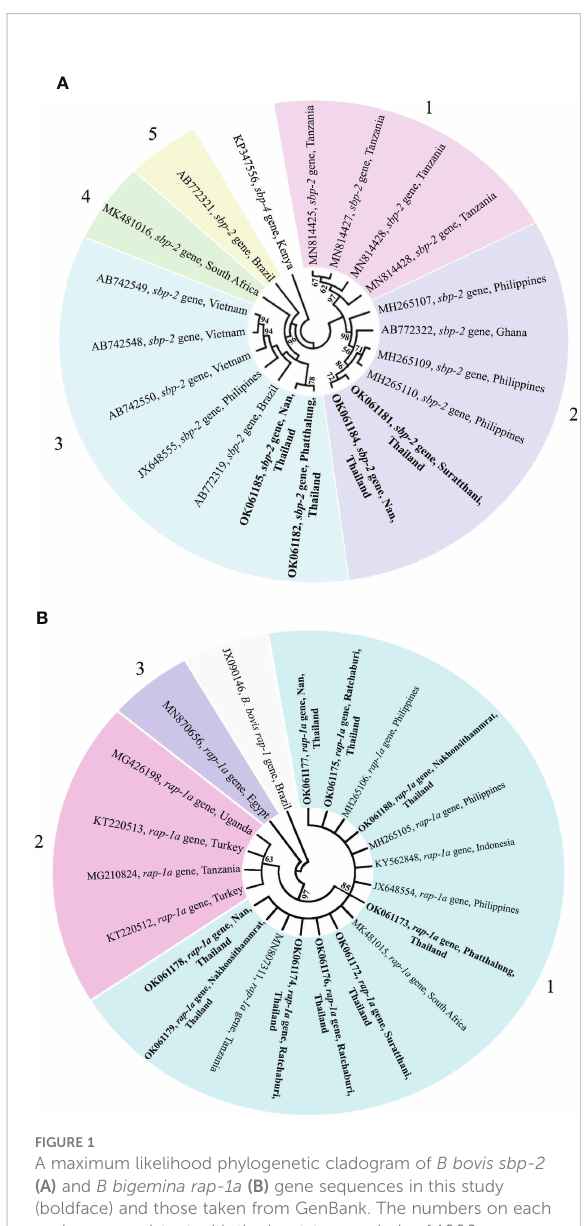
FIGURE 1 A maximum likelihood phylogenetic cladogram of B bovis sbp-2 (A) and B bigemina rap-1a (B) gene sequences in this study (boldface) and those taken from GenBank. The numbers on each node are consistent with the bootstrap analysis of 1000 replicates (only percentage greater than 60% were represented). The GenBank accession numbers of the sequences used in the phylogenetic analysis are exhibited. Two sequences of B bovis sbp-4 (A) and rap-1 (B) gene are used as outer groups. Different colors represent the different